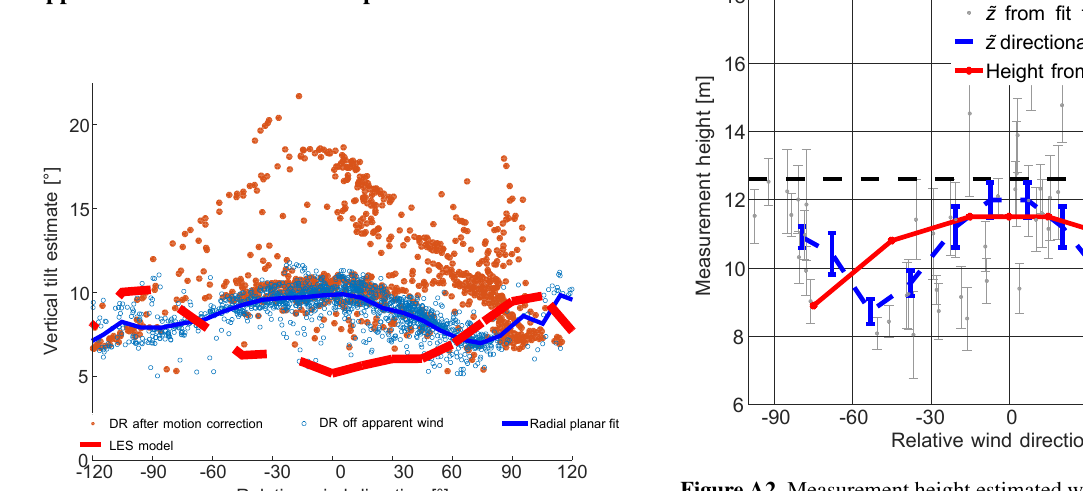
Figure A2. Measurement height estimated with Eq. (A2) as a func- tion of the relative wind direction. Individual measurements are shown as dots with the error bars indicating the uncertainty of the fit. The measurements are averaged over direction bins, this is shown as dashed blue line. The dashed black line indicates the nominal mea- surement height z bow = 12 . 6m and the red curve shows the results from the Gerris large-eddy simulation. Only results obtained from ≤ 0 (with G( z ) = 1) are shown in this fits to unstable spectra z L L plot and were used to estimate e z